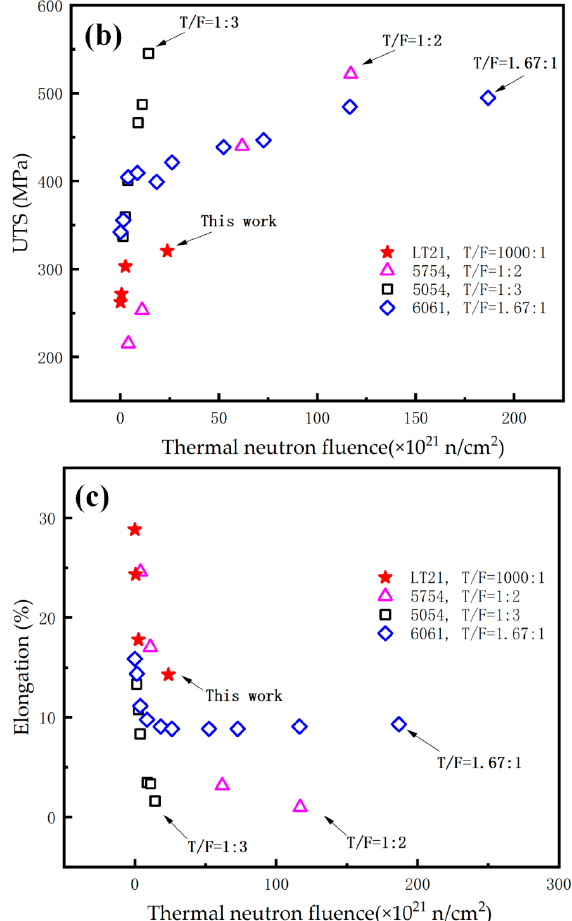
Figure 10. The relationship between ( a ) YS, ( b ) UTS, ( c ) elongation and thermal neutron